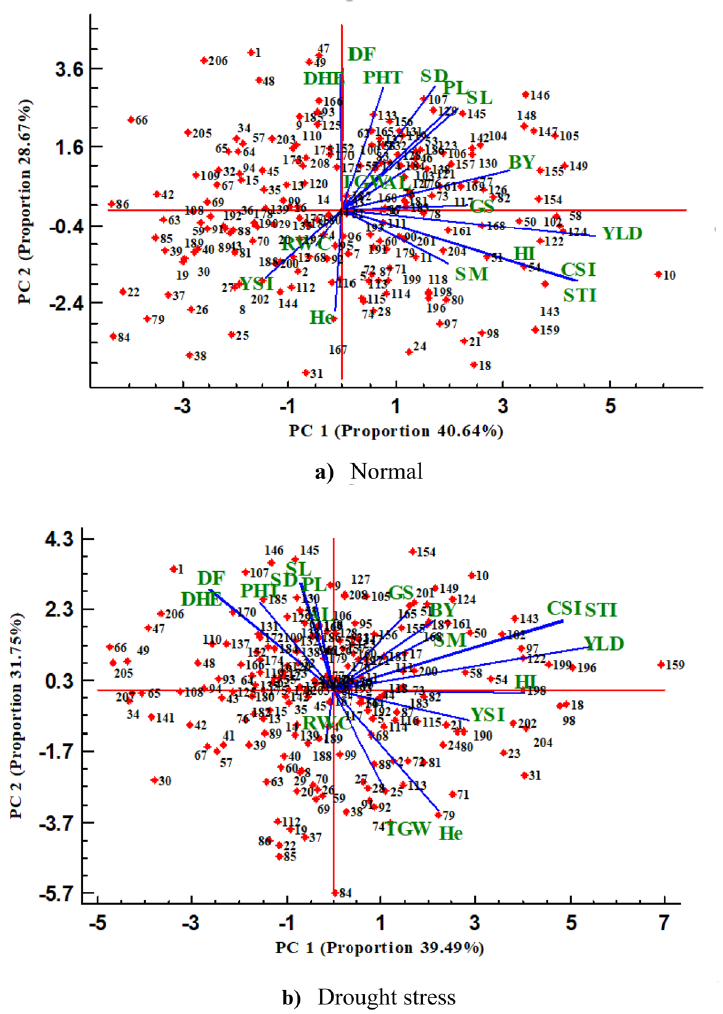
Figure 2. Principal component analysis of traits measured in the synthetic hexaploid wheat derived lines under normal ( a ) and water stress ( b ) conditions. Horizontal and vertical axes are the first and second principal components, respectively. DHE, days to heading; DF, days to flowering; RWC (%), relative water content; PHT (cm), plant height; AL (cm), awn length; SL (cm), spike length; PL (cm), peduncle length; SD, stem diameter (mm); YLD (g/m 2 ), grain yield; SM, spike per m 2 ; TGW (g), thousand-grain weight; GS, grains per spike; He, hectoliter (kg/he); BY (g/m 2 ), biological yield; HI (%), harvest index; STI, stress tolerance index; YSI, yield stability index; CSI, combination of significant indices. The Number of genotypes is according to the first column (Genotype code) in table